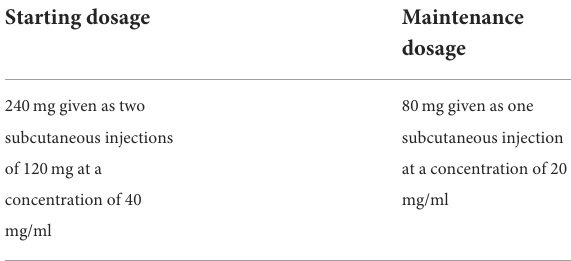
TABLE 2 Medication regimen of degarelix acetate for